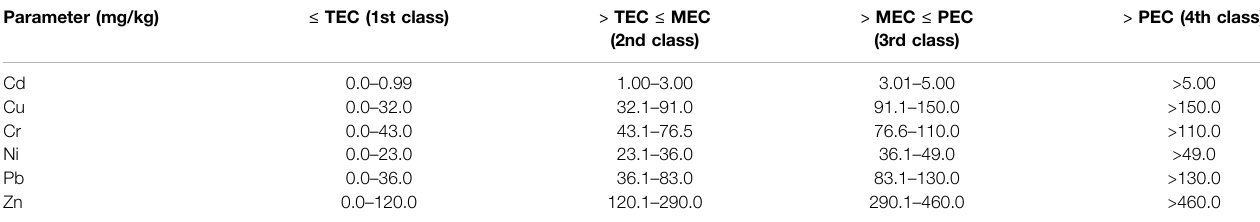
TABLE 1 | Classi fi cation of metals in sediments using the ecotoxicological method. Parameter (mg/kg)